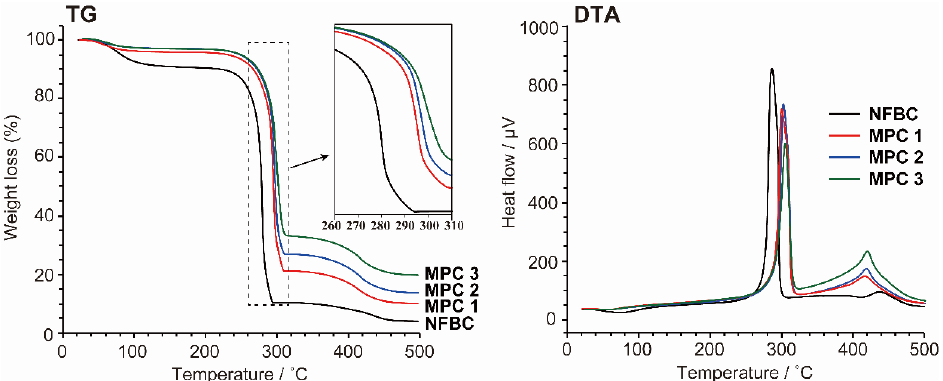
Figure 4. Thermal gravimetry/differential thermal analysis (TG/DTA) data for MPC 1–3 and NFBC.